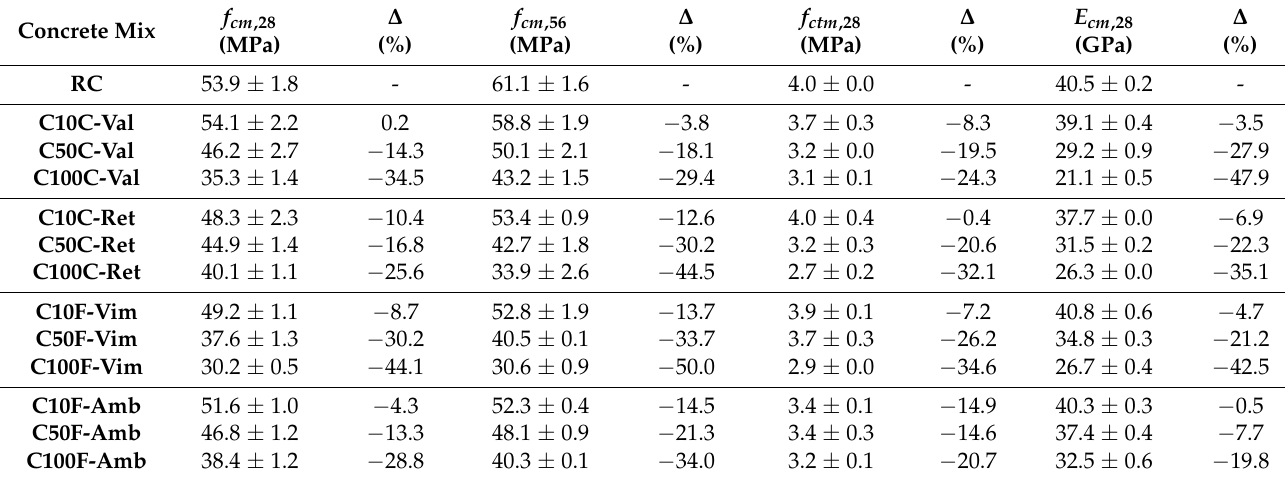
Table 7. Mechanical properties of the concrete mixes with RA from CDW and their variation ( ∆ ) with respect to the RC. f cm ,28 Concrete Mix